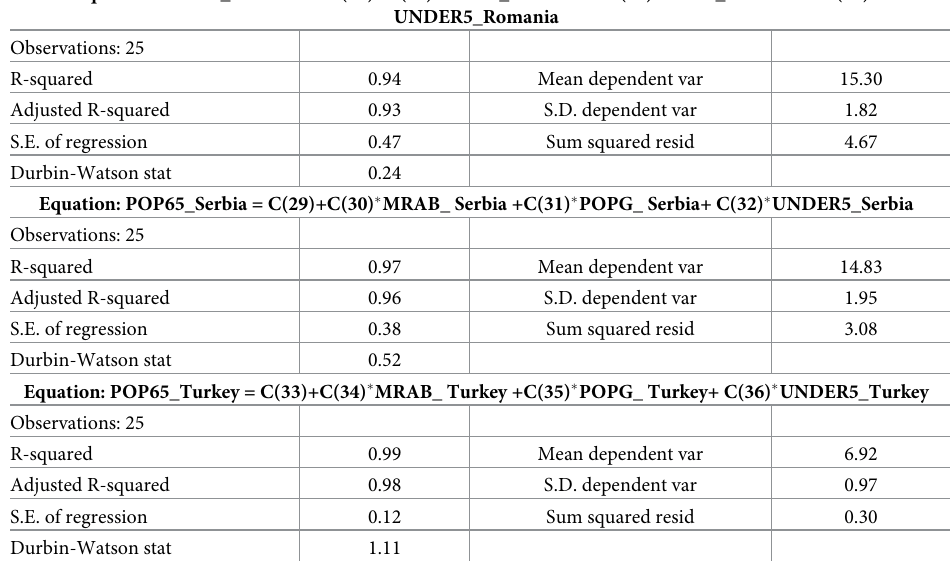
Table 5. System estimation by country